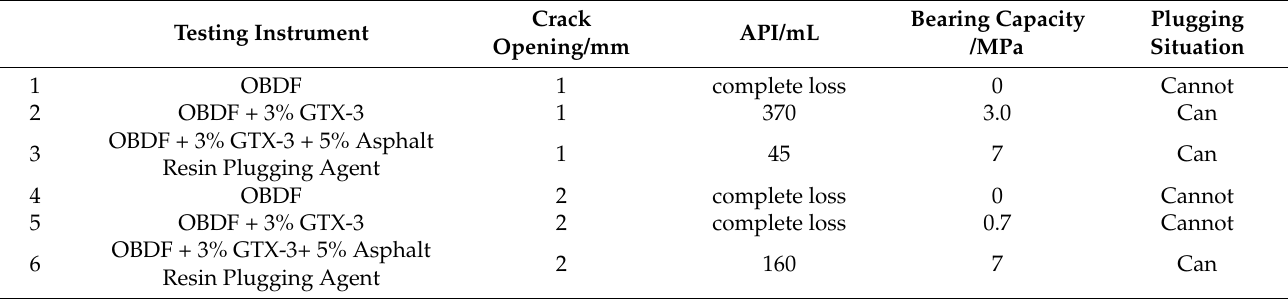
Table 9. Plugging test on crack plates with different crack